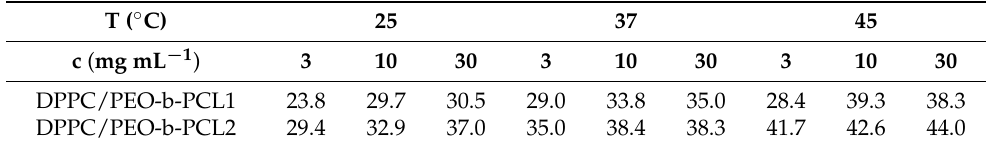
Table 2. Percentage of mass concentration of vesicles relative to the nominal DPPC mass concentration ( c ves / c · 100). The uncertainty δ c/c on the presented concentrations is about